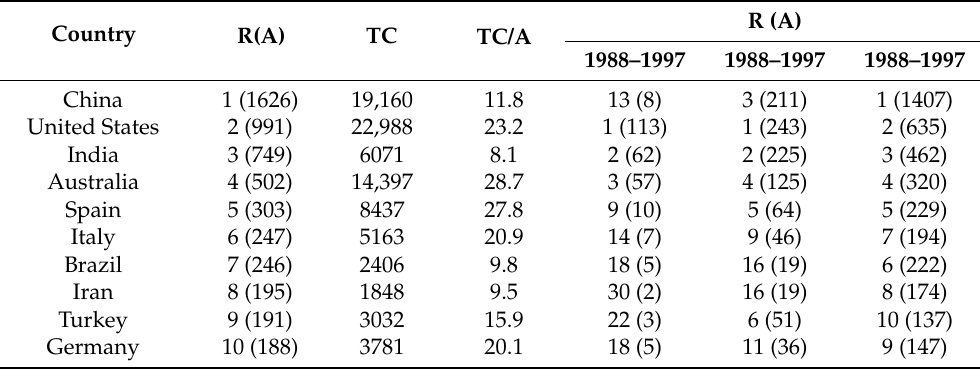
Table 3. Most productive countries for WUEA research from 1988 to